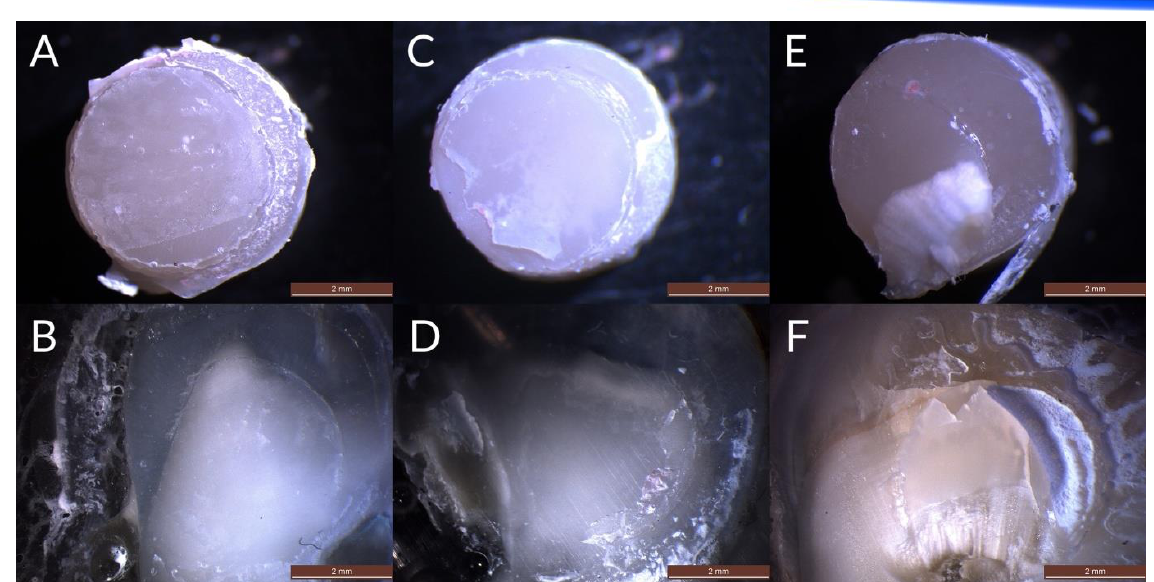
Figure 4: Representative images of failure mode of ceramic surface (CS) (ACE) and dentin surface (DS) (BDF) in group MBP (A,B) Adhesive; (C,D) Cohesive; (E,F) Mixed.